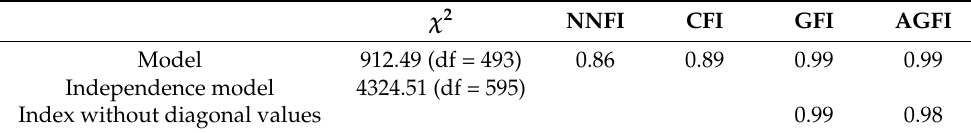
Table 3. Goodness of fit